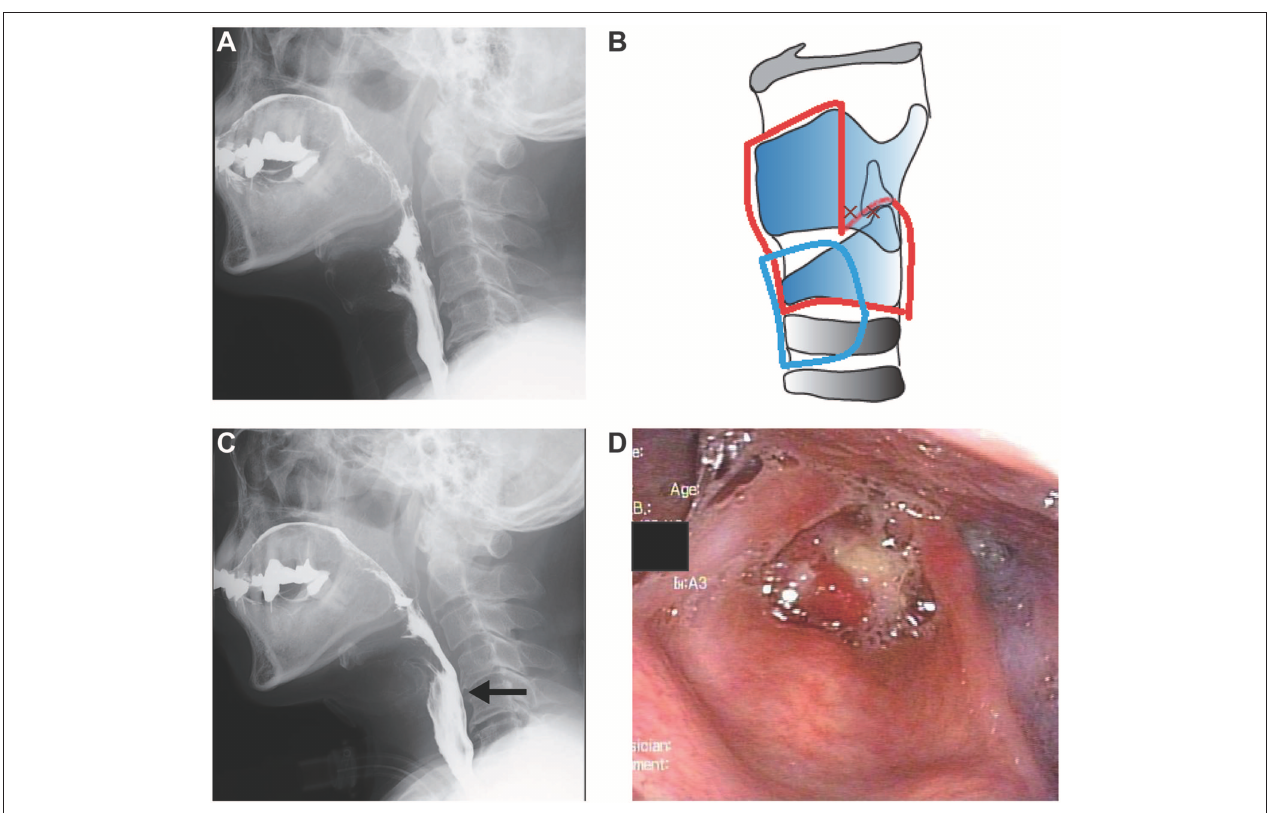
FIGURE 3 | Clinical findings in case 3. (A) Preoperative videofluoroscopic swallowing study (VFSS). (B) Operative schema. The removed area is encircled by a red line, and the permanent tracheostoma is located in the area surrounded by a blue line. (C) Postoperative VFSS. The arrow shows sufficient upper esophageal sphincter opening. (D) Postoperative laryngeal fiberoscopic